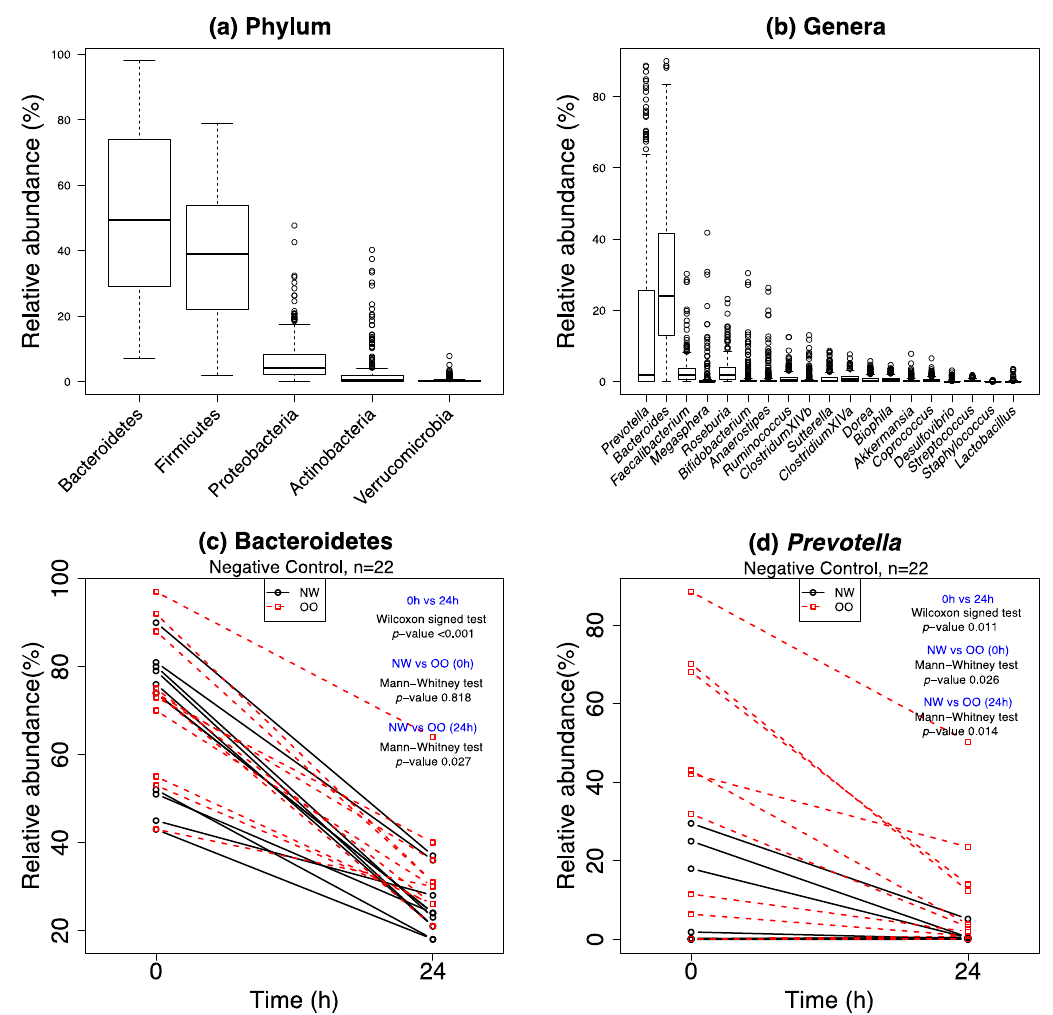
Figure 2. Dynamics of microbiota (phylum and genera level) in in vitro fermentation. In ( a , b ), the distribution of microbiota is depicted in the boxplot sorted by largest variance. In ( c , d ), the time effect, 0 h vs. 24 h, is shown and tested by a Wilcoxon signed test, and the group difference between NW and OO is tested by a Mann–Whitney test under the negative control ( n = 22) for two selected microbiota.